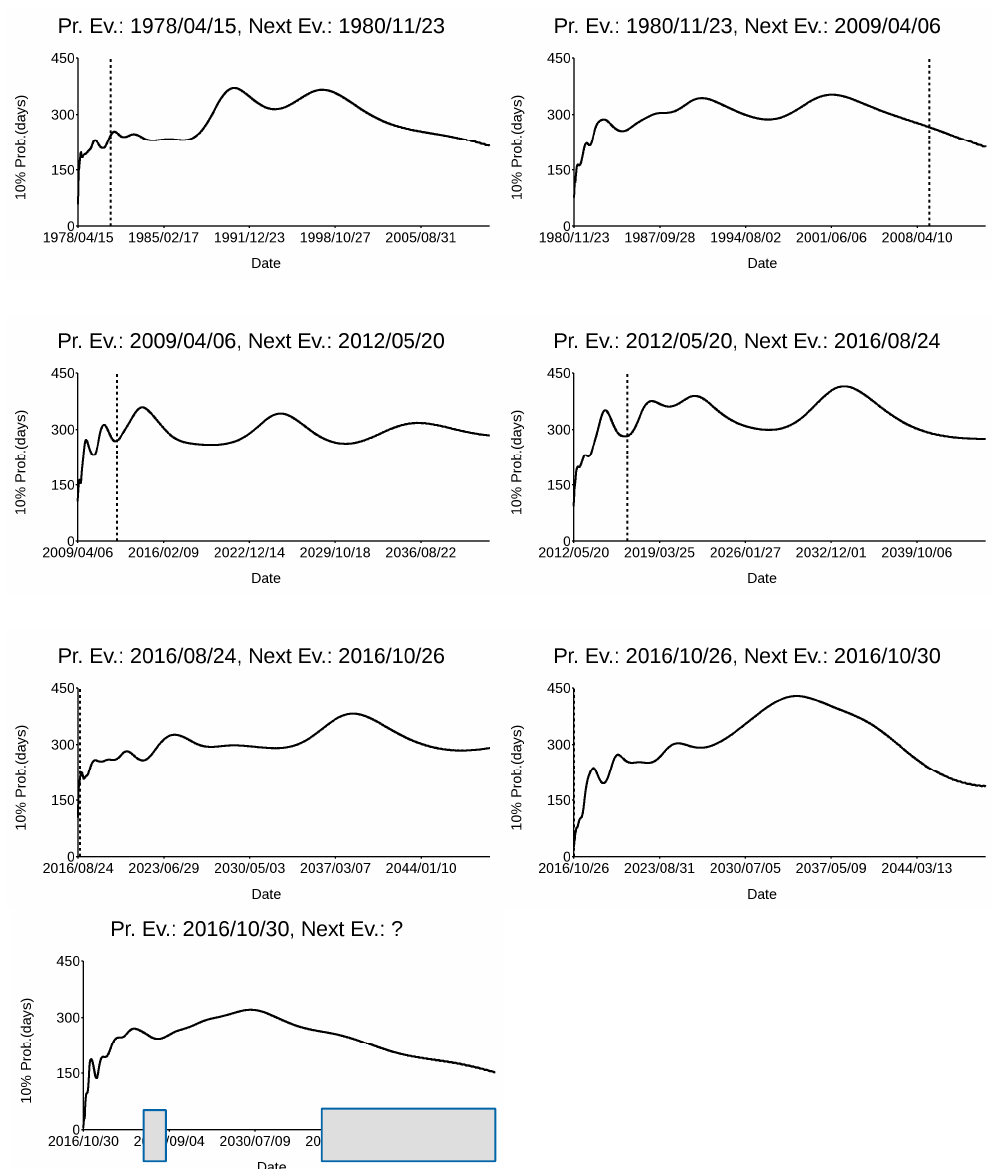
Figure 9. Daily length (in days) of the 10 % occurrence probability after each of the last seven major events that struck Italy. The dashed line refers to the date of occurrence of the following event. Gray areas correspond to the periods of most probable occurrence of the next large event.